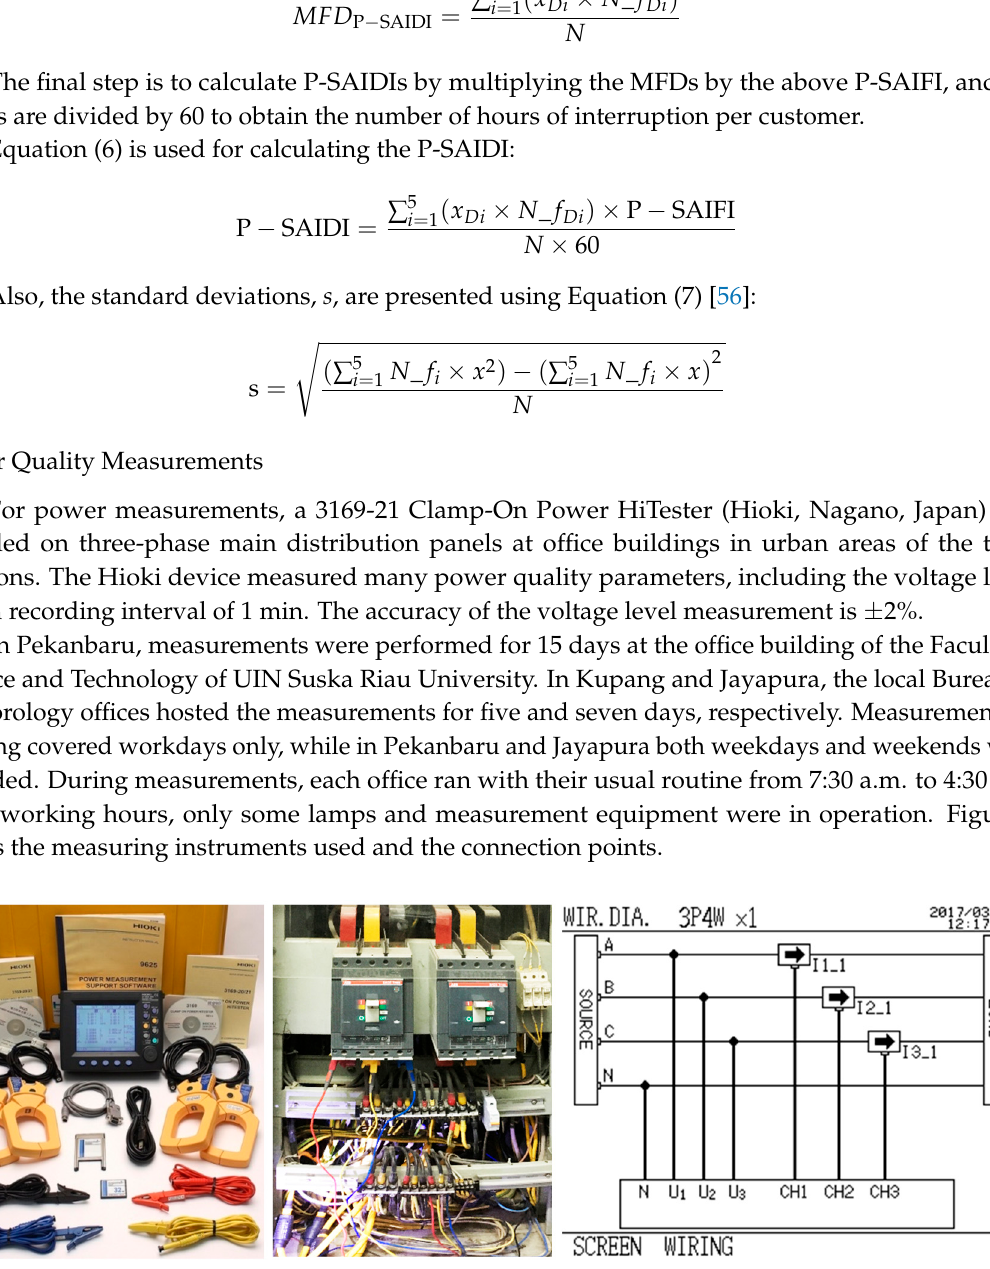
Figure 2. Hioki 3169-21 Clamp-On Power HiTester measuring power quality (PQ).